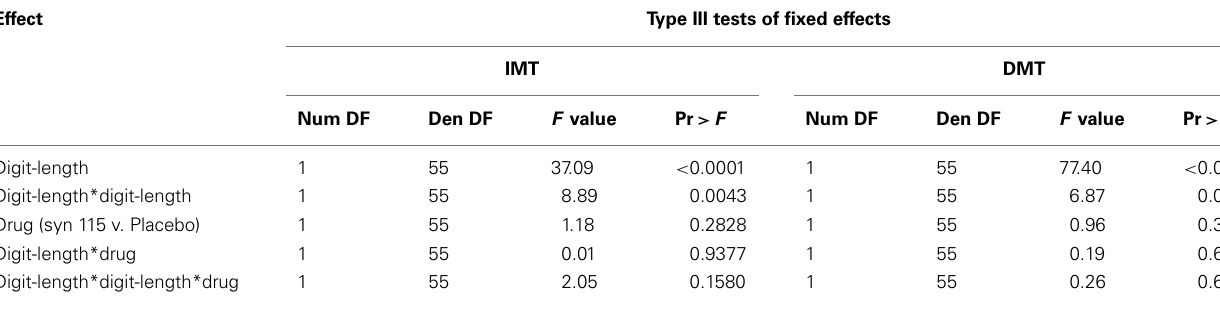
Table 3 | Results of statistical analysis of behavioral data model with interactions.